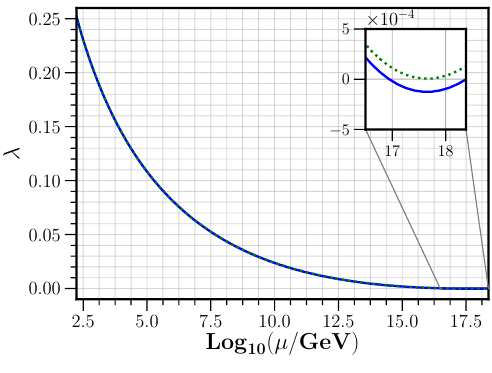
Figure 2 . Running of the Higgs quartic coupling with the logarithm of the renormalisation scale µ in the SM using the 2-loop RGEs. We used the values given in eq. (3.1) for M t = 170 . 97 GeV (solid blue line) and M t = 170 . 96 GeV (dotted green line). The difference between requiring λ ( M pl ) = 0 or λ ≥ 0 , respectively the solid blue and dotted green lines, only yields a tiny correction to λ or M t